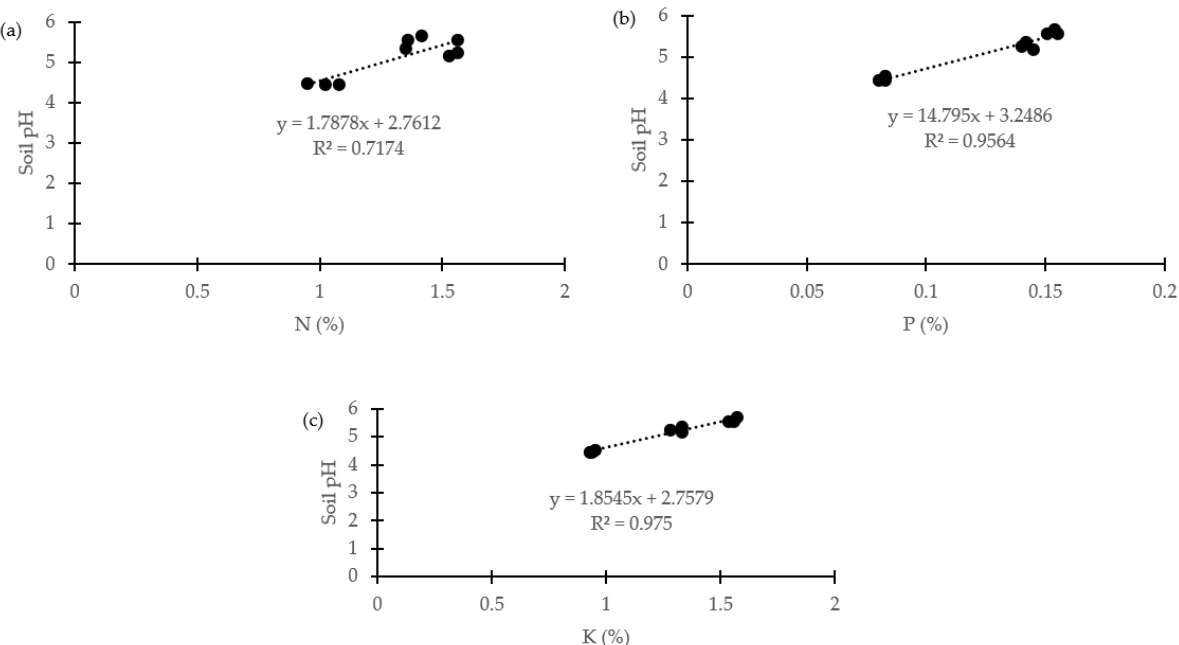
Figure 2. Relationship between soil pH and plant macronutrients with ( a ) N: nitrogen, ( b ) P: phos- phorus, and ( c ) K: potassium (data are means of treatments). Table 1. The effects of different treatments on the chemical properties of